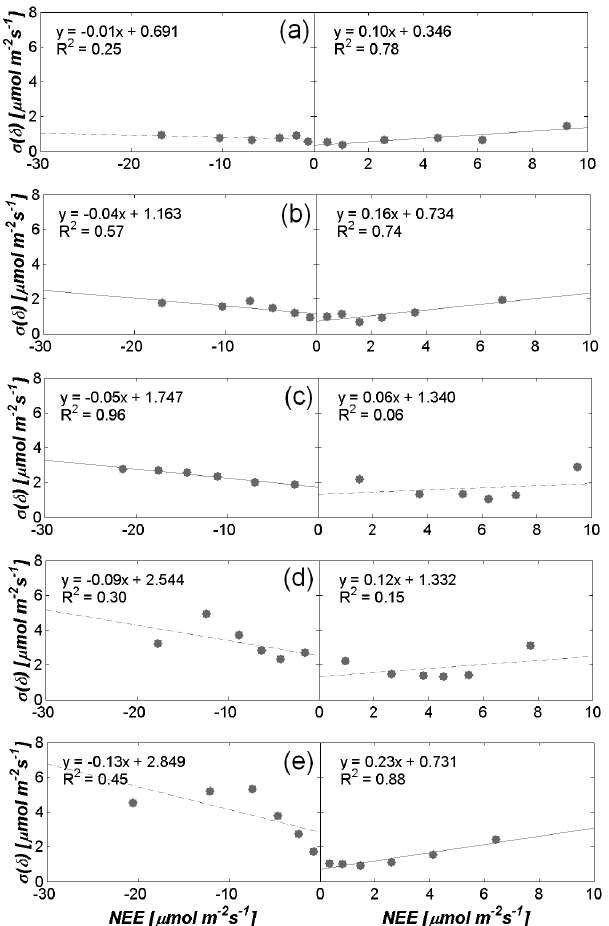
Figure 2. NEE uncertainty σ(δ) determined with the classical two- tower approach as function of the NEE flux magnitude for the EC tower distances 8m (a) , 95m (b) , 173m (c) , 20.5km (d) and 34km (e) ; dashed line: linear correlation not significant ( p > 0.1).